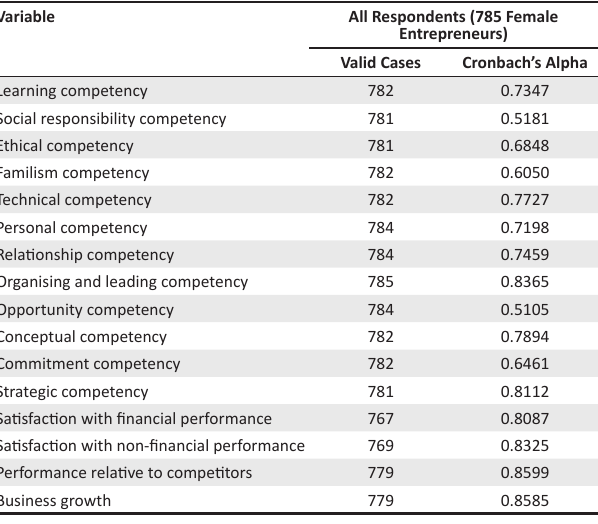
TABLE 2: Reliability analysis.